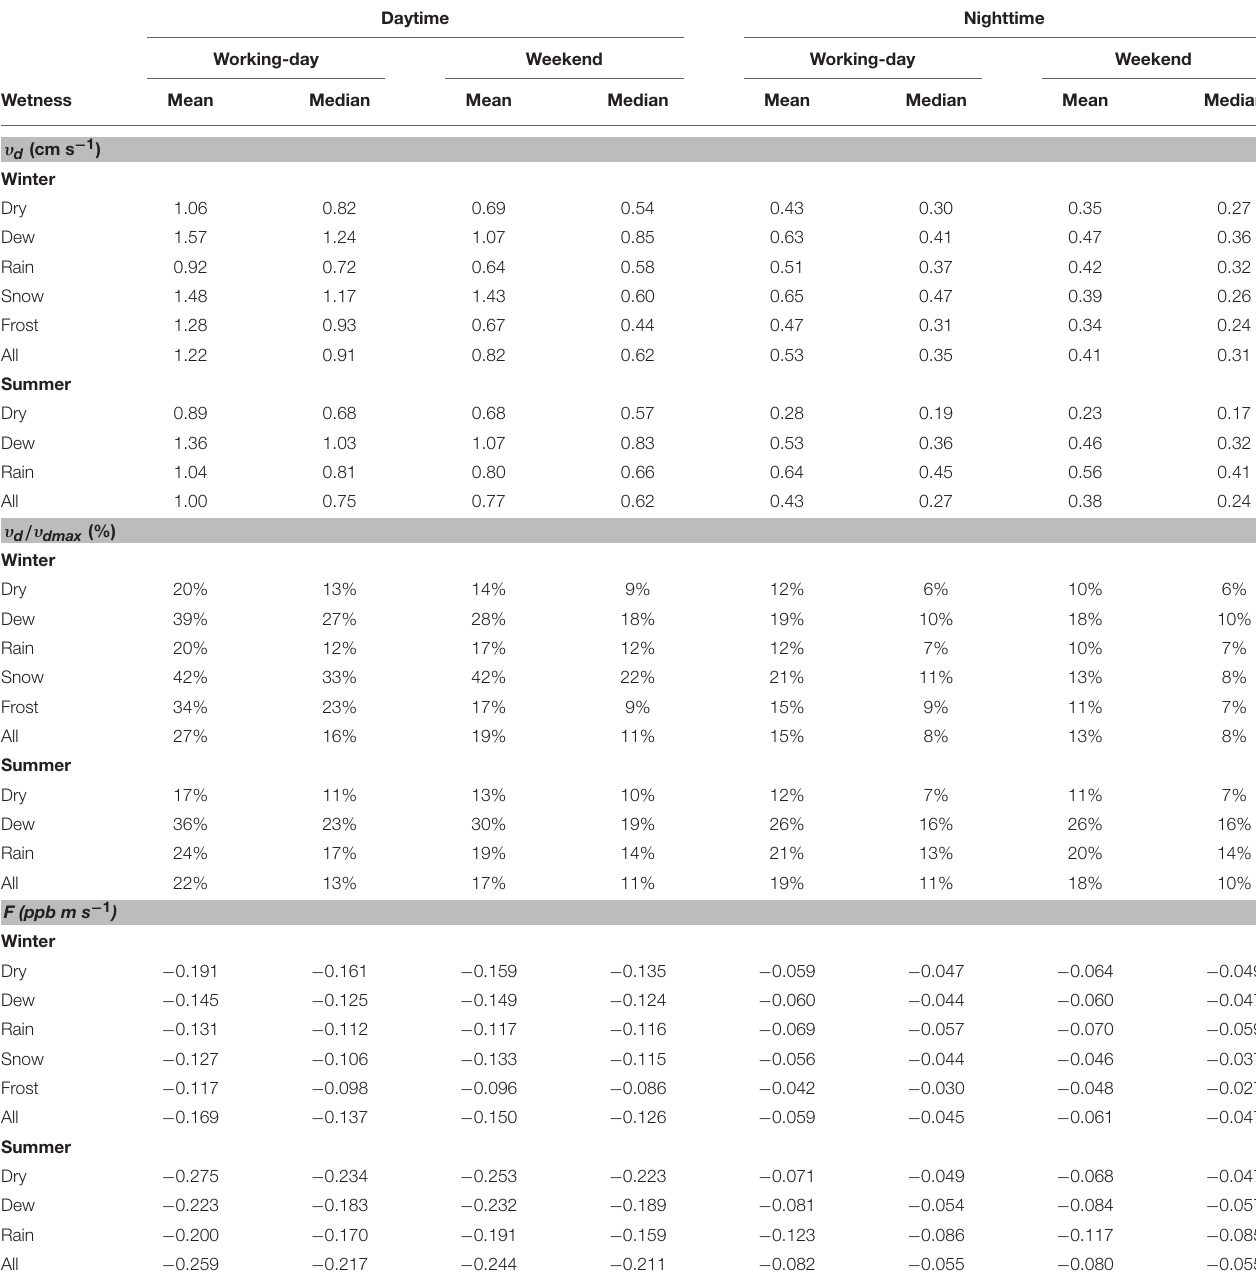
Daytime Nighttime Working-day Weekend Working-day Weekend